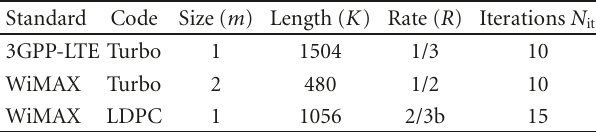
Table 1: Reference codes for the simulation scenario. Standard Code Size ( m ) Length ( K ) Rate ( R ) Iterations N it 3GPP-LTE